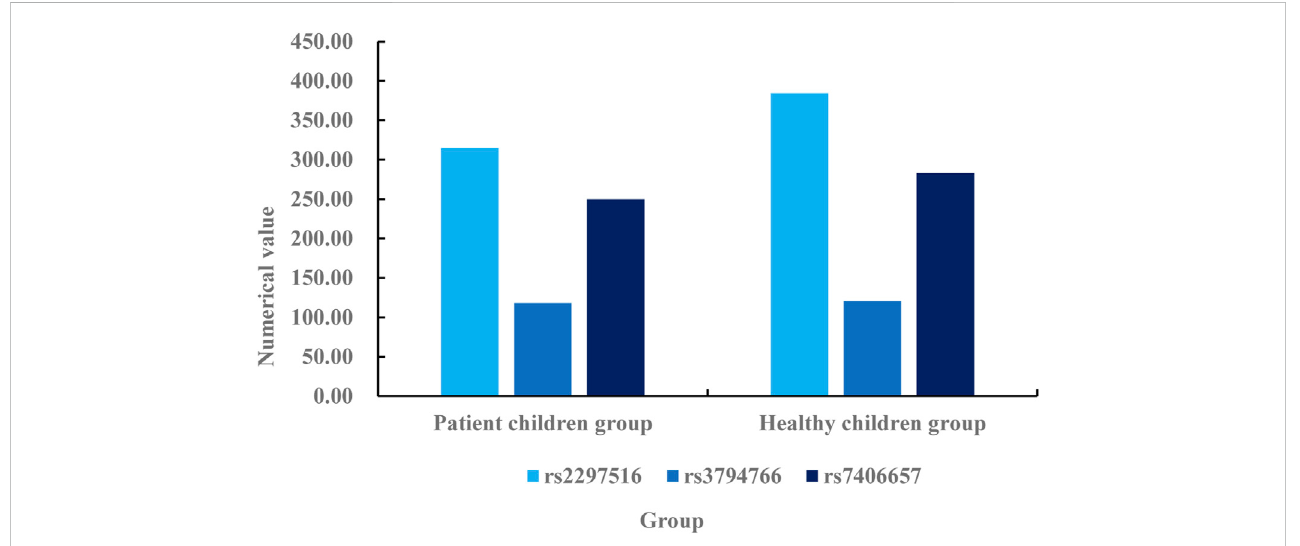
FIGURE 4 Comparison of allele frequency difference of NOS2 between two groups of children.